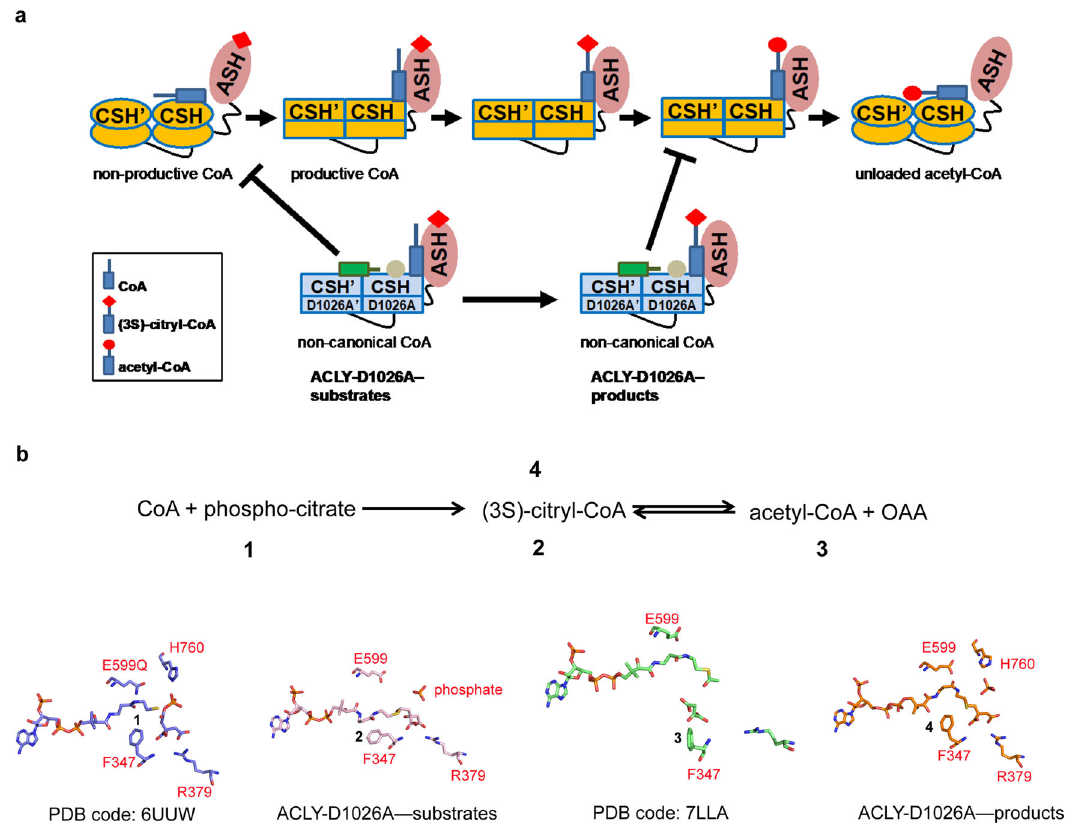
Fig.6|AllostericregulationoftheCSHdomaininACLYcatalysisandinhibition ofproductformationinACLY-D1026A.a Model2forACLYcatalysis,asillustrated in Fig. 1, with the mechanism of inhibition by the ACLY-D1026A mutant based on the structures of ACLY-D1026 – substrates and ACLY-D1026A – products. Different bound states of CoA and acetyl-CoA are annotated below the corresponding